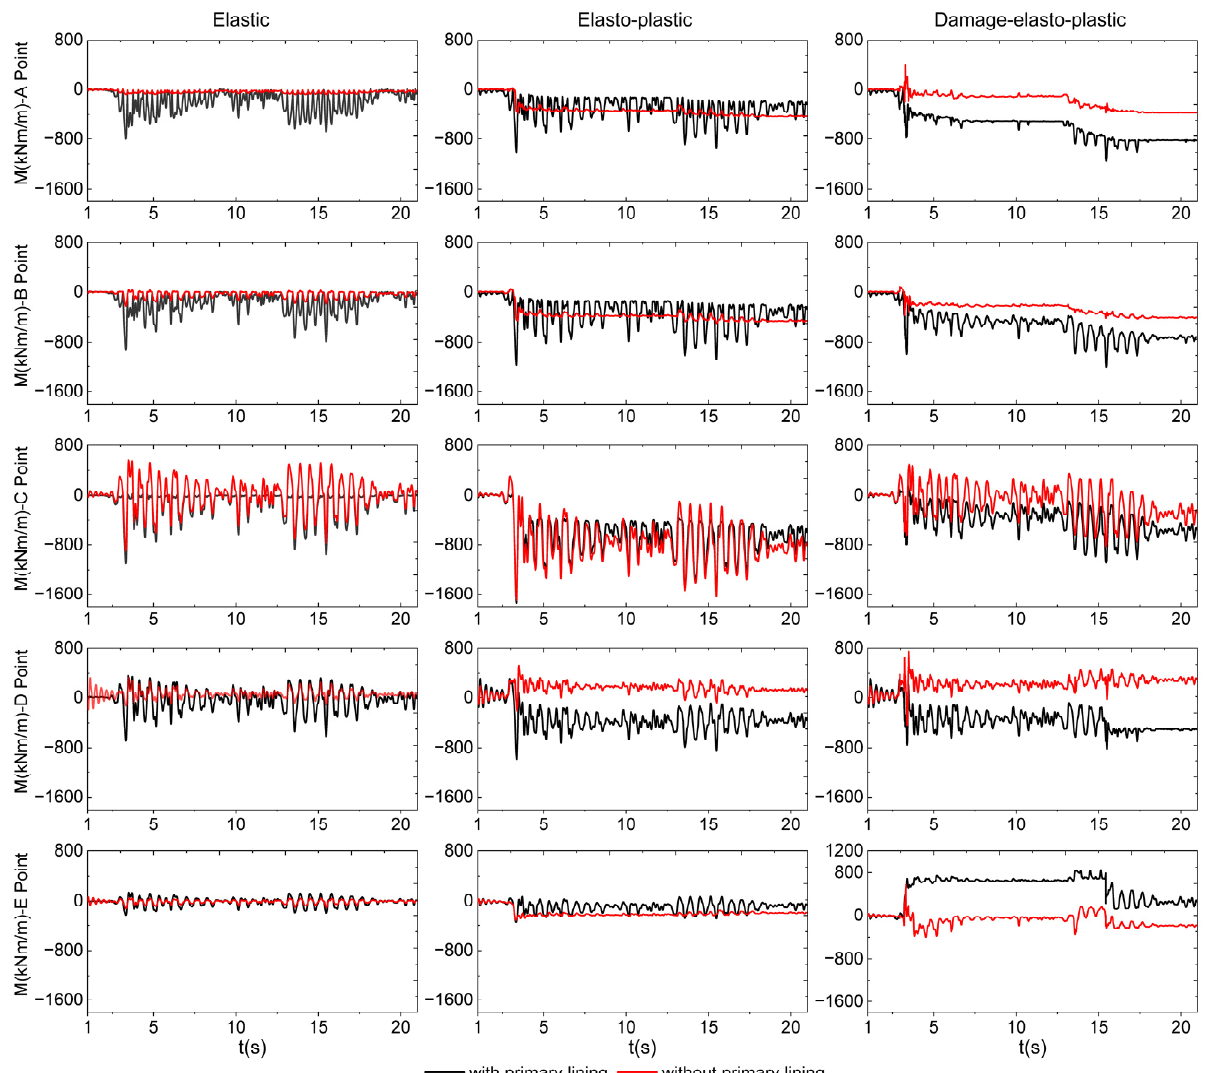
Figure 15. Dynamic bending moment time histories at the crucial section of tunnel (A/B/C/D/E) computed for EQ1. First column: elastic analysis result. Second column: elasto-plastic analysis result. Third column: damage plastic analysis result.